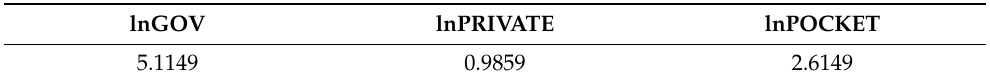
Table 6. Order of Importance of Public Health Expenditures, Private Health Expenditures, and Out-Of-Pocket Health Expenditures for Economic Growth.